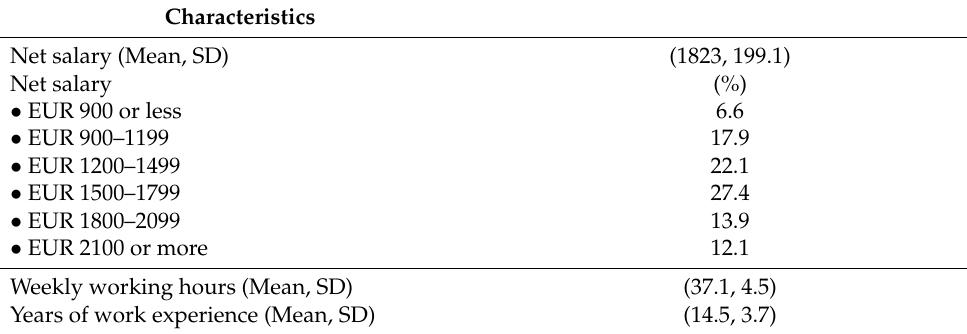
Table 2. Socioeconomic characteristics of the participants.